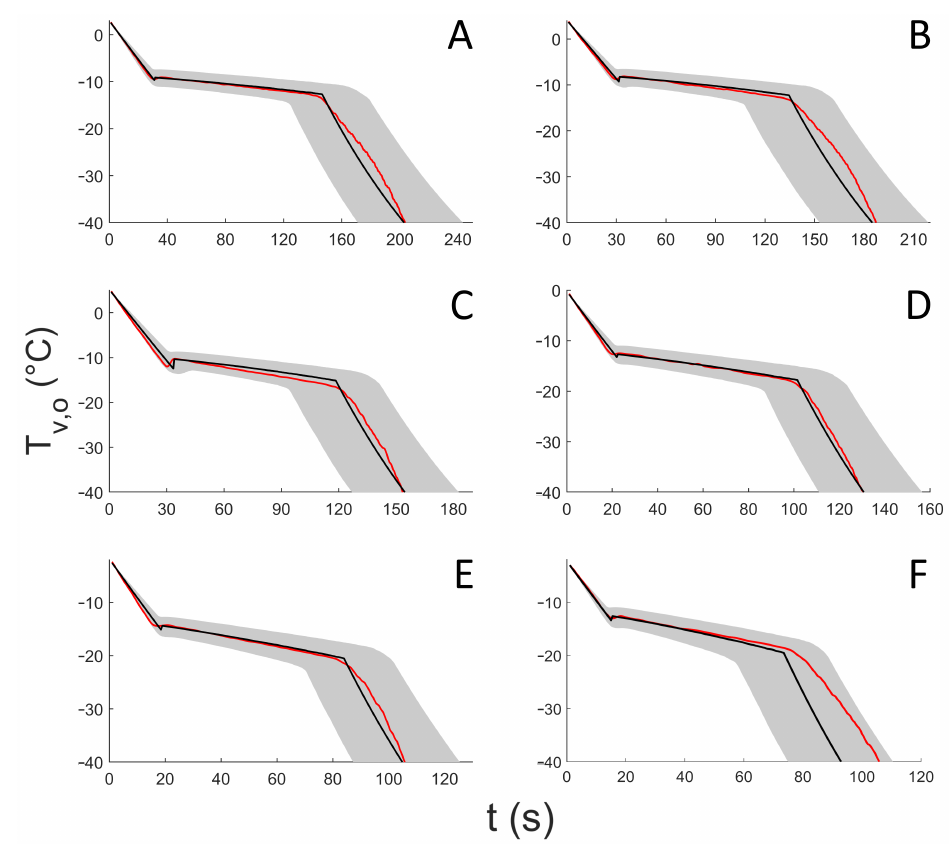
Figure 6. Uncertainty analysis of outer vial wall temperature profiles during cooling and freezing for 6 constant gas flow rates. The red solid lines represent outer vial wall temperature data from experiments as measured by the infrared camera. The black solid lines represent the model prediction of the outer vial wall temperature based on the model input parameters, assuming that no uncertainty is present on the model input parameters. The gray areas indicate the prediction interval of the model prediction of the outer vial wall temperature, taking the uncertainty in the model input parameters into account. Data of the following constant gas flow rates are displayed: A: 32 L/min, B: 44 L/min, C: 50 L/min, D: 56 L/min, E: 68 L/min, and F: 80